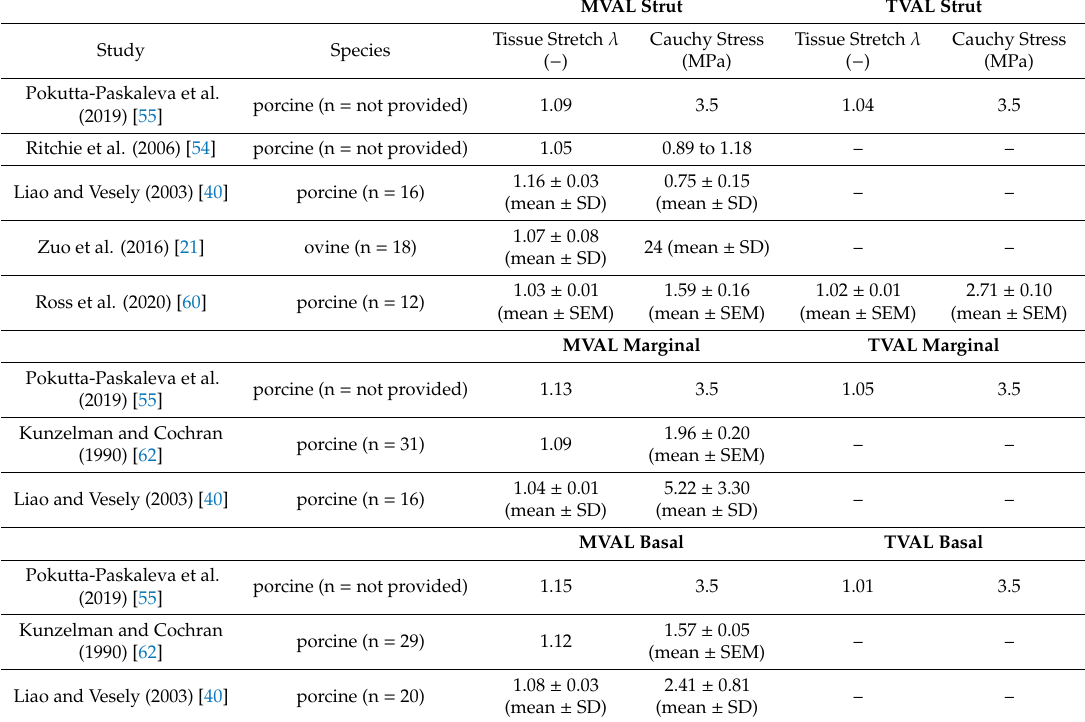
Table 1. Comparisons of the reported uniaxial mechanical testing results (tissue stretch versus Cauchy stress) of the chordae tendineae of the mitral valve anterior leaflet (MVAL) and tricuspid valve anterior leaflet (TVAL). MVAL Strut TVAL Strut Tissue Stretch λ Species ( −